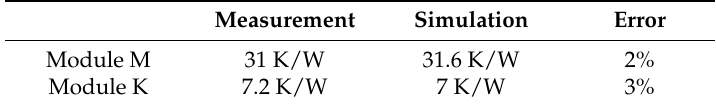
Figure 7. Thermal resistance measurement setup:( a ) Principle; ( b ) Top view of the open insulated box (Module M). Table 2. Comparison between measured and simulated results of power terminals thermal resistances R pt . The error is defined by: (maximum value—minimum value)/(minimum value).